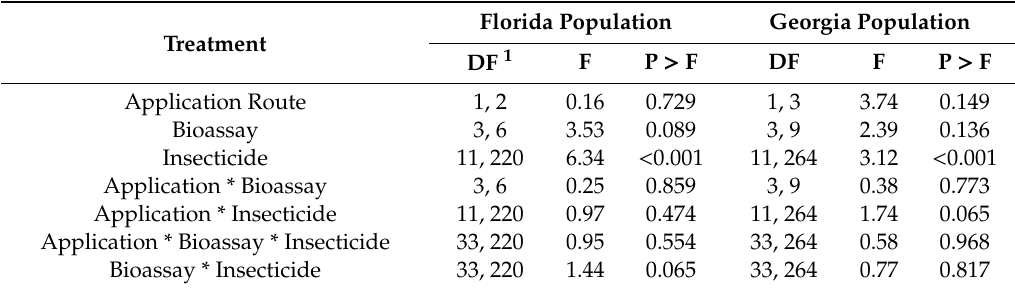
Table 2. E ff ects of treatments and their interactions on egg numbers for a Florida and Georgia whitefly population, Coastal Plain Exp. Station, Tifton, GA, USA, 2019.